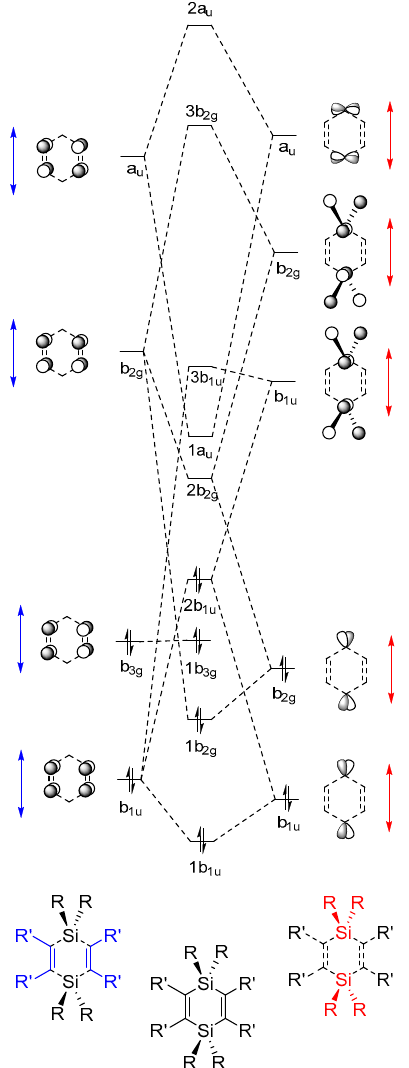
Figure 7. Qualitative molecular orbital (MO) diagrams of 1,4-disilacyclohexa-2,5-diene with the lowest few occupied and unoccupied MOs of π -character constructed from suitable fragment orbitals. Red arrows indicate changes in fragment orbital energies in dependence of substituent R and blue arrows indicate changes of substituent R ′ . The orbitals are labeled in accordance with the irreducible representations of the D 2h point group, and the ordering is that of 2a according to PBE0/6-31G(d) calculations.